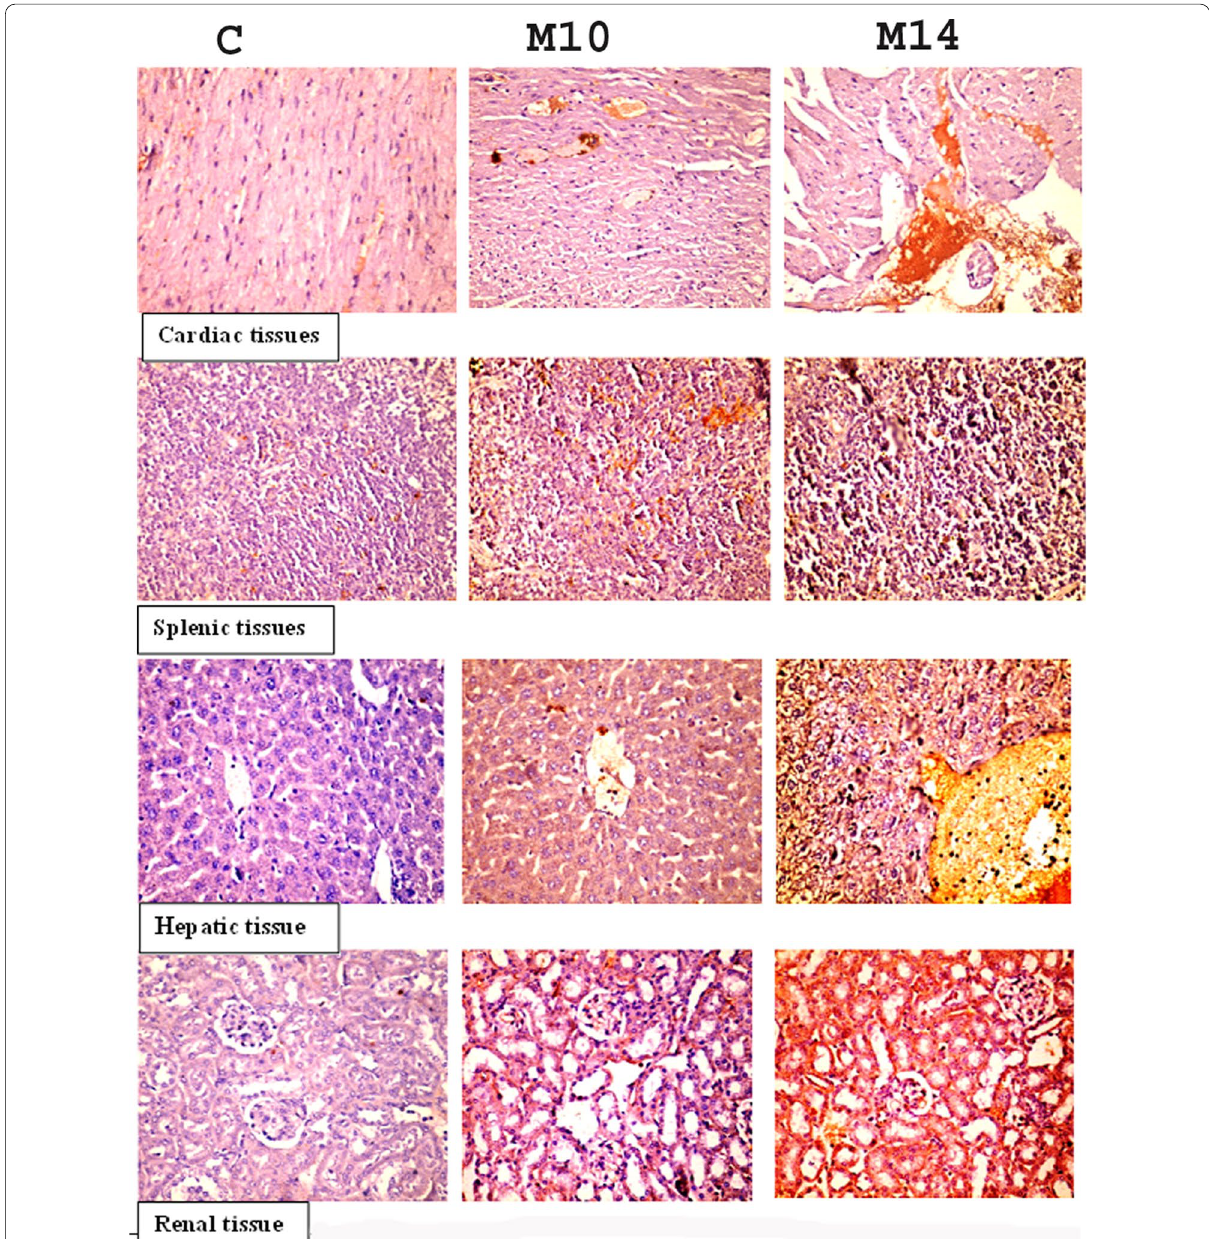
Fig. 5 A photomicrograph of sections from cardiac, splenic, hepatic and renal staining with Immunohistochemistry staining of NF κB, X200: (C) Control group; (M10) monosodium glutamate treated mice for 10 days and (M14) monosodium glutamate treated mice for 14 days. Brown color: positive expression of NF